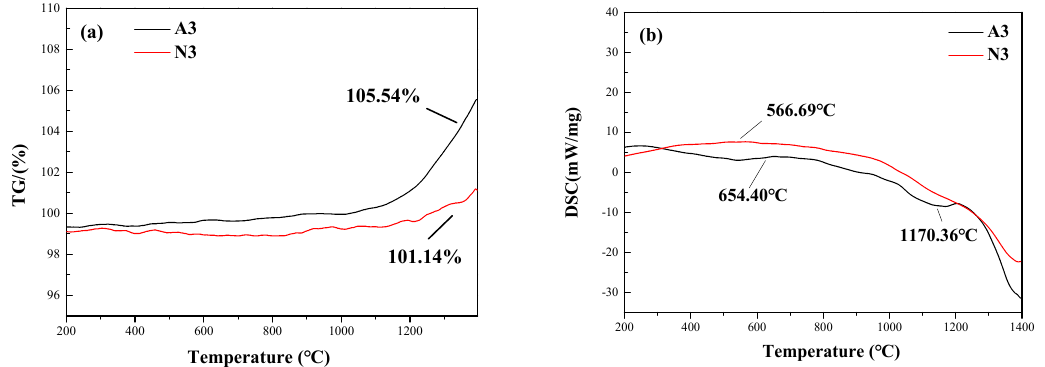
Figure 9. ( a ) Thermogravimetric (TG) and ( b ) differential scanning calorimetry (DSC) curves of A3 and N3 samples.